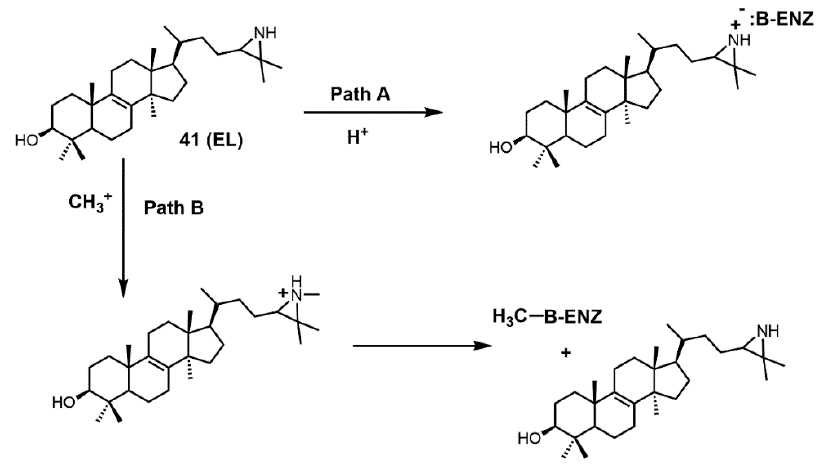
Figure 23. Proposed pathways for inhibition of sterol C24-methyltransferase (24-SMT) with 24( R,S )- 25-epiminolanosterol (EL) (adapted from [92]).